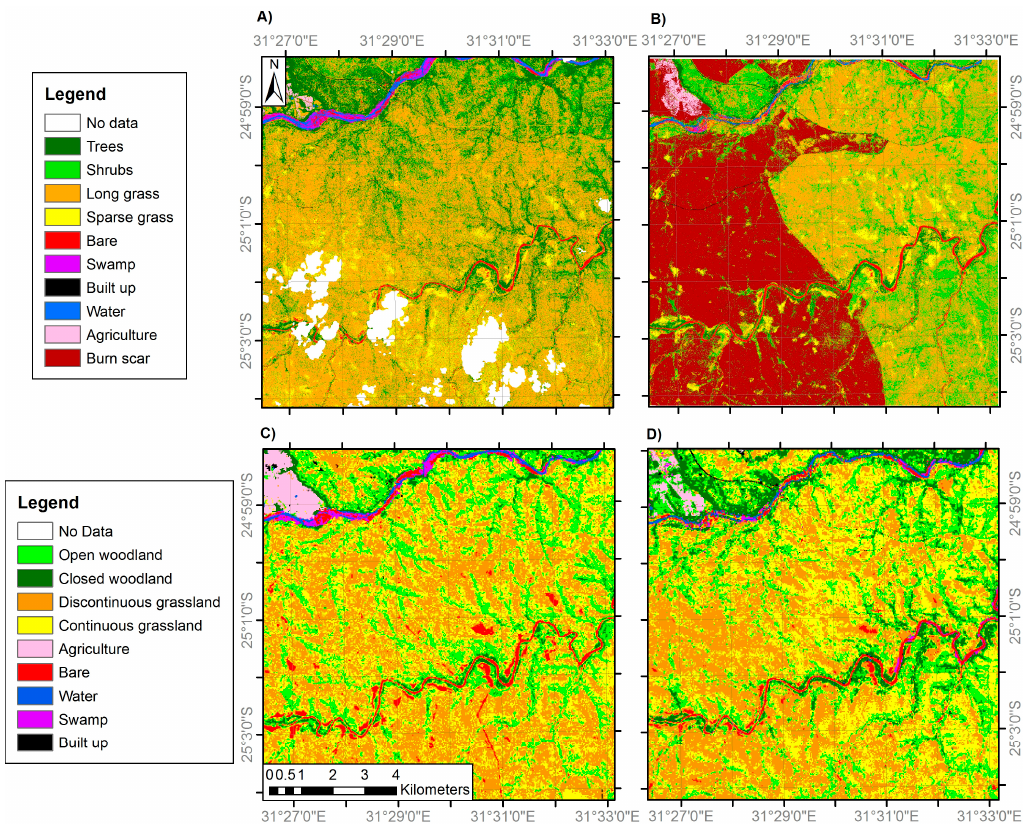
Figure 4. Land cover classifications of site 2 generated from: ( A ) VHR IKONOS imagery (4 m resolution) in 2002; ( B ) VHR IKONOS imagery (4 m resolution) in 2014; ( C ) medium resolution Landsat ETM+ imagery (30 m) in 2002; and ( D ) medium resolution Landsat OLI imagery (30 m) in 2014. Areas of ‘No Data’ correspond to areas of cloud cover and cloud shadow. Note the woodland and grassland class definitions differ between the fine and medium resolution classifications (Table 2). Table 3. Land cover change between February 2001 and 2014 calculated using VHR imagery. To ensure that the overlap between sites 1 and 2 was not double-counted in the ‘total’ area calculations, the part of site 1 in the overlap area (more affected by cloud) was excluded when the ‘total’ columns were calculated. Cover change % corresponds to percentage of the full site area.